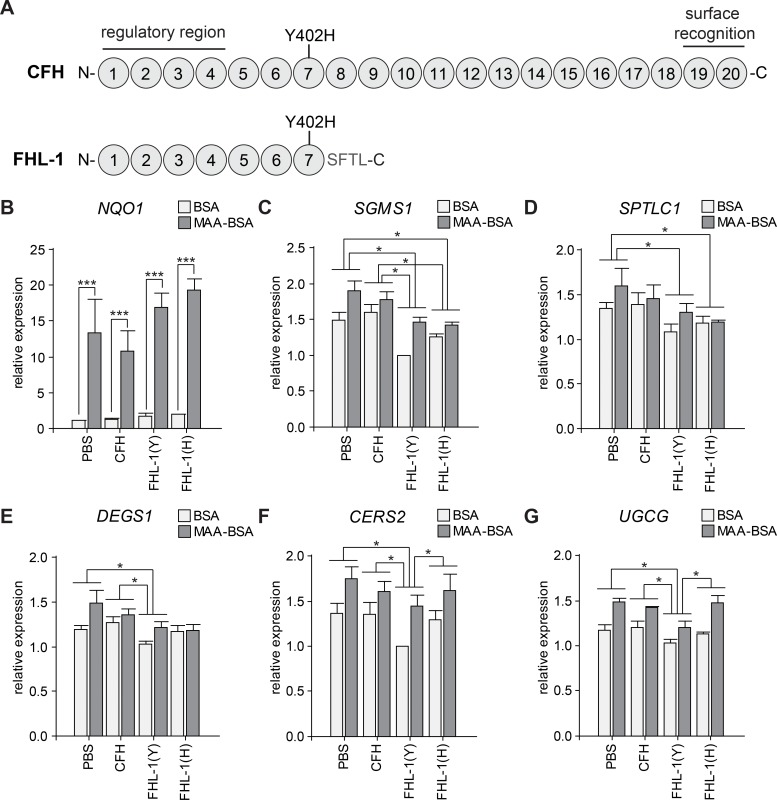
Influence of FHL-1 variants in expression of ceramide metabolism genes.(A) Schematic representation of CFH and FHL-1 proteins. CFH is composed of 20 short consensus repeats (SCR), and its alternative splicing variant FHL-1 of 7 SCR and a unique extension of 4 amino acids. The complement regulatory region (SCR 1–4), and surface recognition domains (SCR 19–20) are indicated. Residue 402 is located in the SCR 7 of both proteins. (B-G) WERI-Rb1 cells treated with 80 μg/mL BSA or MAA-BSA during 24 h with or without addition of 200 μg/mL CFH or 80 μg/mL FHL-1 proteins. Expression of genes from (B) NAD(P)H dehydrogenase [quinone] 1 (NQO1), (C) Phosphatidylcholine:ceramide cholinephosphotransferase 1 (SGMS1), (D) Serine palmitoyltransferase 1 (SPTLC1), (E) Sphingolipid delta(4)-desaturase DES1 (DEGS1), (F) Ceramide synthase 2 (CERS2), (G) Ceramide glucosyltransferase (UGCG). Each value corresponds to the mean ± SEM of four-fold independently performed experiments. Statistics: two-way blocked ANOVA and Tukey’s test (no significant interaction between principal effects was observed); (C-G) only the significance from the Tukey’s test comparing PBS, CFH, FHL-1:Y402 (Y), and FHL-1:H402 (H) are shown in the graphs; all genes showed significant differences between MAA-BSA and BSA treatments: (C, F) p<0.001, (G, E) p<0.01, (D) p<0.05. ***p<0.001, *p<0.05.